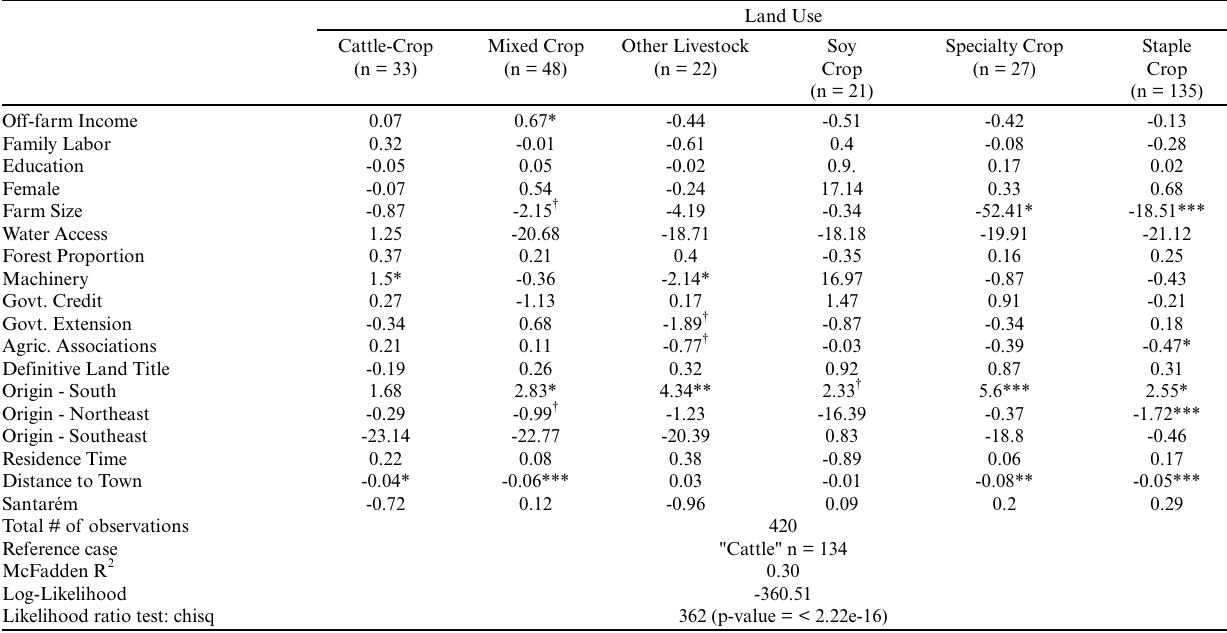
Table 2 . Results for multinomial logit land use model.